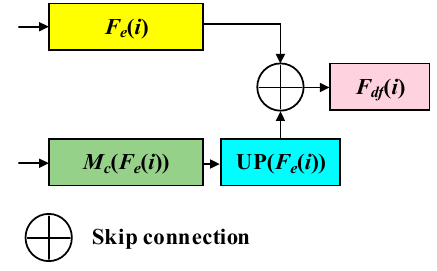
Figure 4. The Pipeline of DFA.